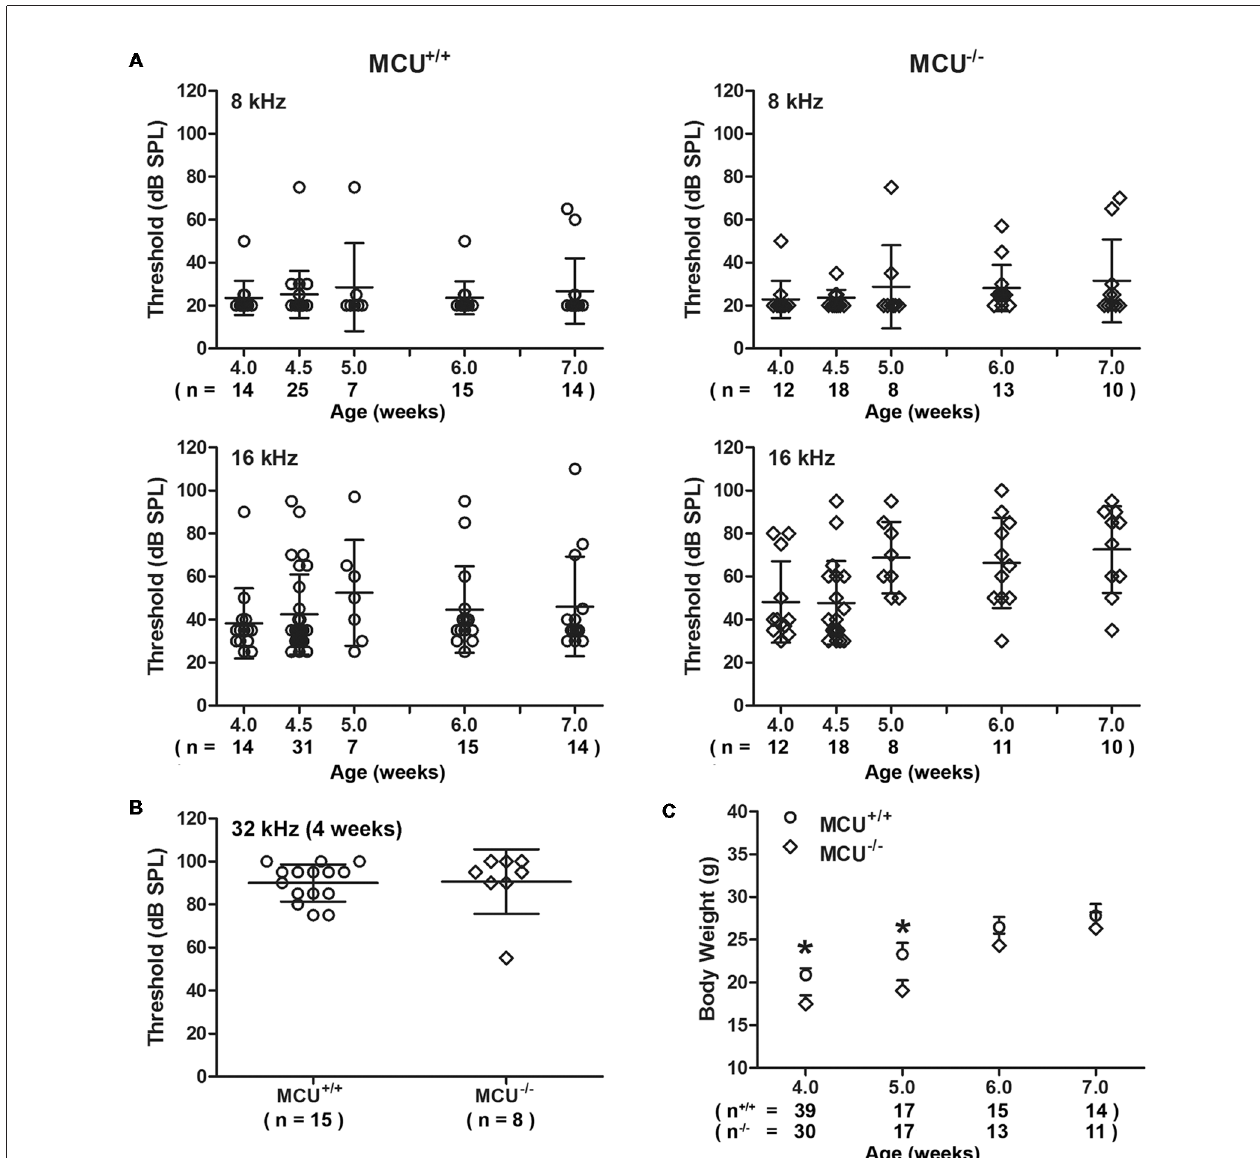
FIGURE 6 | MCU knockout mice (MCU − / − ) and wild-type littermates (MCU + / + ) on a hybrid CD1 and C57/B6 background had OHC loss in the basal turn and high-frequency hearing loss. (A) Auditory brainstem response (ABR) thresholds at 8 kHz were not significantly elevated and not different between MCU − / − mice and MCU + / + from weeks 4 to 7 weeks of age but displayed wide variations at 16 kHz. Data are presented as individual points and means ± SD. (B) ABR thresholds at 32 kHz were greatly elevated in 4-week-old MCU − / − and MCU + / + mice without a significant difference between these two groups. Data are presented as individual points and means ± SD. (C) Body weights of MCU − / − mice were significantly lower than that of littermates at the age of 4–5 weeks, but were the same as wild-type littermates by 6 weeks. Data are presented as individual points and means ± SEM, ∗ p < 0.05. In panels (A,B) n indicates the number of mice per group with one cochlea used per mouse, n in panel (C) indicates the number of